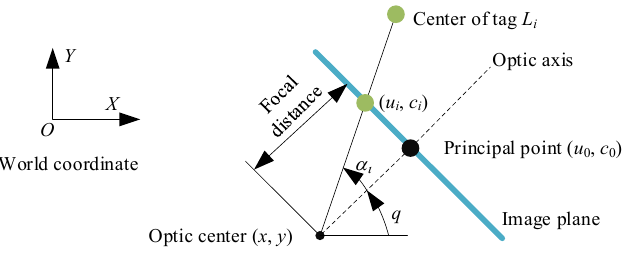
Figure 3. Angle measurement by vision.